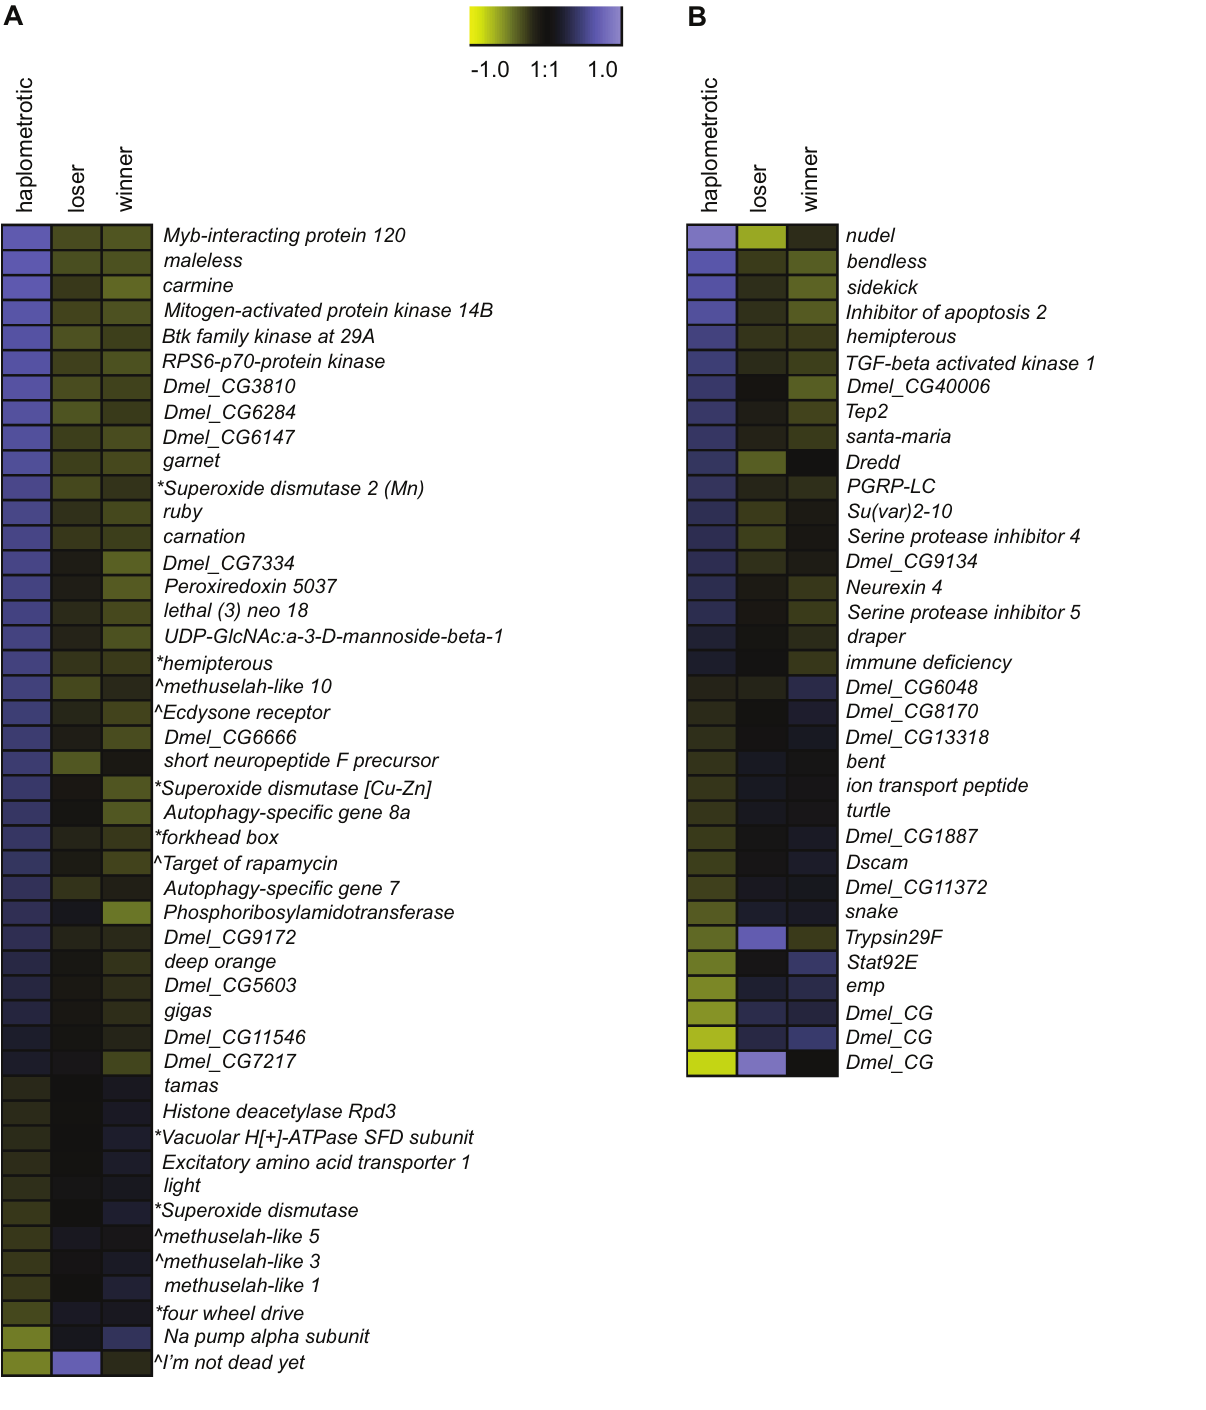
Figure 3. Expression patterns of aging- and immune-associated genes. A) Heatmap of log2 transformed and normalized expression values for the fire ant transcripts that are putatively involved in aging processes. This gene list was obtained by overlapping the list differentially regulated transcripts with FlyBase matches in experiment 1 with the list of genes included in the Drosophila GO term ‘‘aging’’. The directional expression of these transcripts was also compared to the expression patterns of aging genes as found in the review by Paaby and Schmidt [65]. *=gene that extends lifespan when its activity is increased; ‘ =gene that extends lifespan when its activity is decreased. B) Heatmap of log2 transformed and normalized expression values for the fire ant transcripts that are putatively involved in immune processes. This gene list was obtained by overlapping the list differentially regulated transcripts with FlyBase matches in experiment 1 with the list of canonical immune-related genes annotated in honey bees